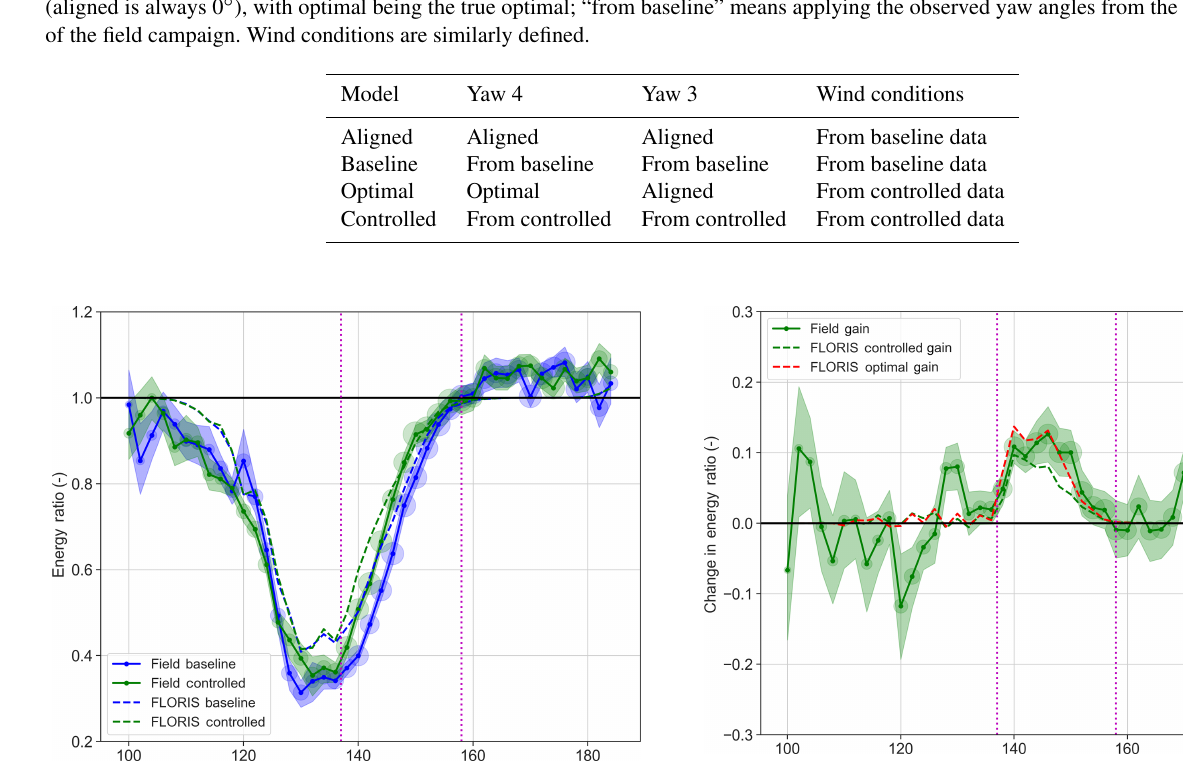
Figure 11. Energy ratio for T3 for field data and the baseline and controlled FLORIS cases (see Table 1). An energy ratio of 0.5 cor- responds to a production of 50% of the total expected based on the measured inflow without considering wakes. The vertical magenta lines indicate the region where control is applied and a difference between the baseline and controlled is expected. The size of the cir- cles at each point indicates the number of points in the bin, while the bands indicate 95% confidence as computed by bootstrapping.